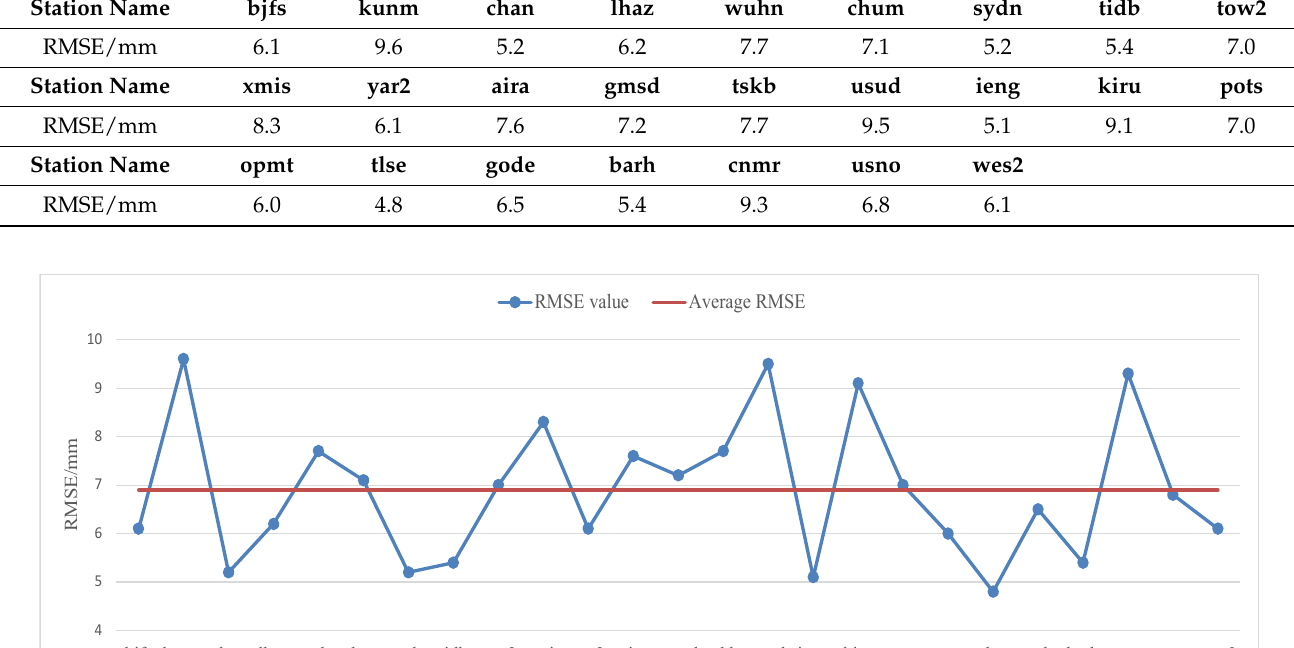
Table 4. RMSE indicators of elevation nonlinear LS period modeling for 25 CORS stations around the world.